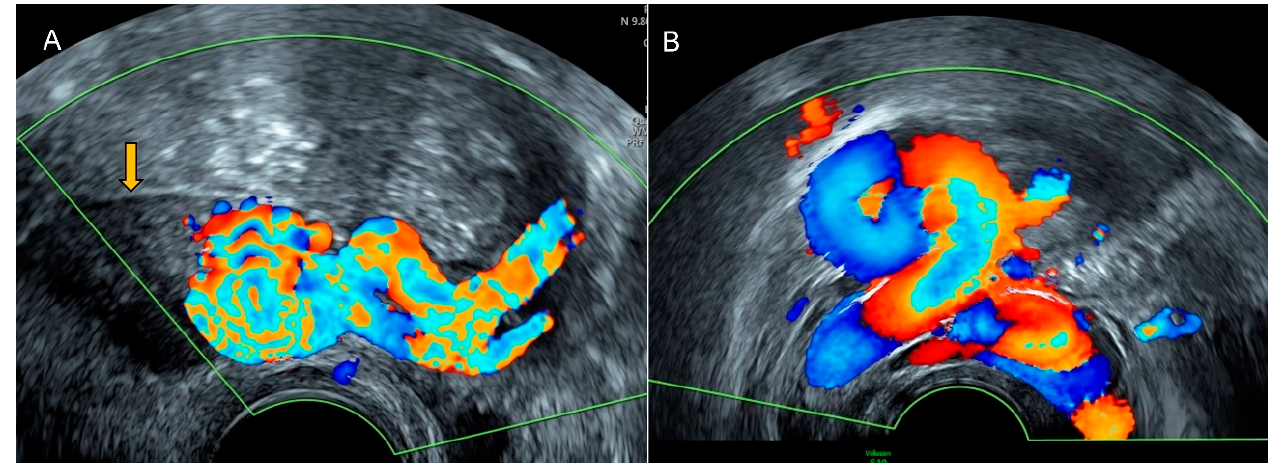
Figure 18. Color Doppler transvaginal ultrasound ( A , B ) demonstrates dilated and tortuous arcuate uterine vessels communicating with varicose pelvic veins. Uterus is indicated with yellow arrow ( A ).